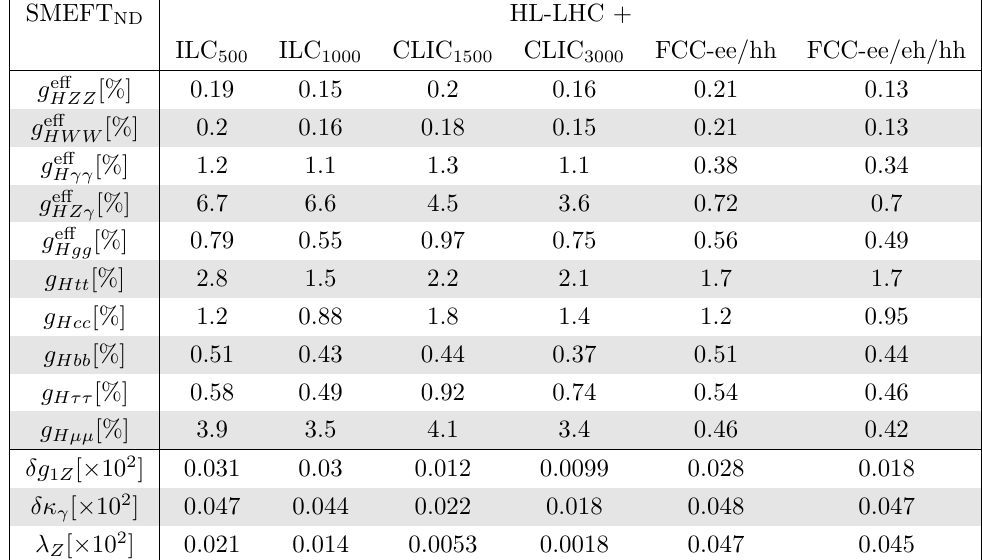
Table 35 . E(cid:11)ective Higgs couplings precision for the EFT (cid:12)t for a selection of colliders at high energy. For the linear colliders it is assumed that 100 fb (cid:0) 1 of dedicated running on the Z-pole, corresponding to 1-3 years of data taking, are part of the programme.